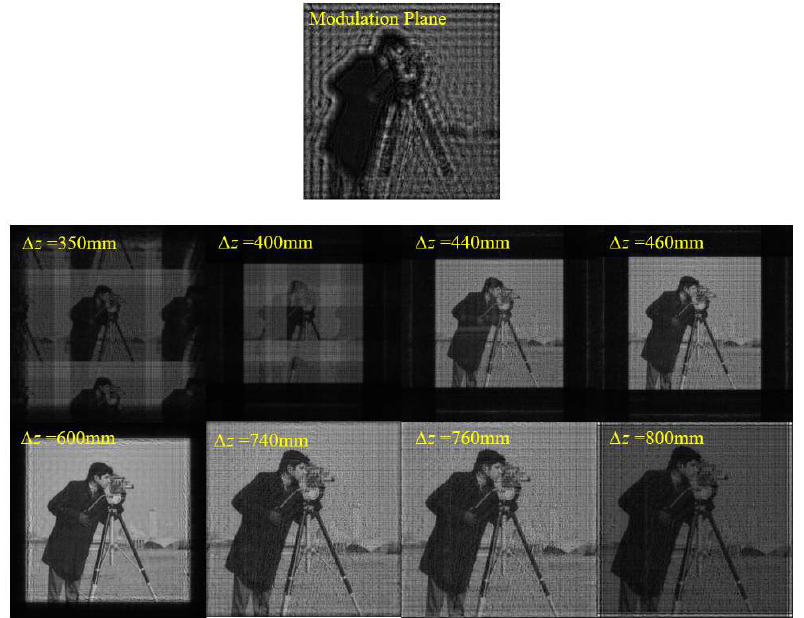
Figure 3. Initial (modulation) plane and calculated amplitude distributions on the diffraction plane with different ∆ z using SFD.